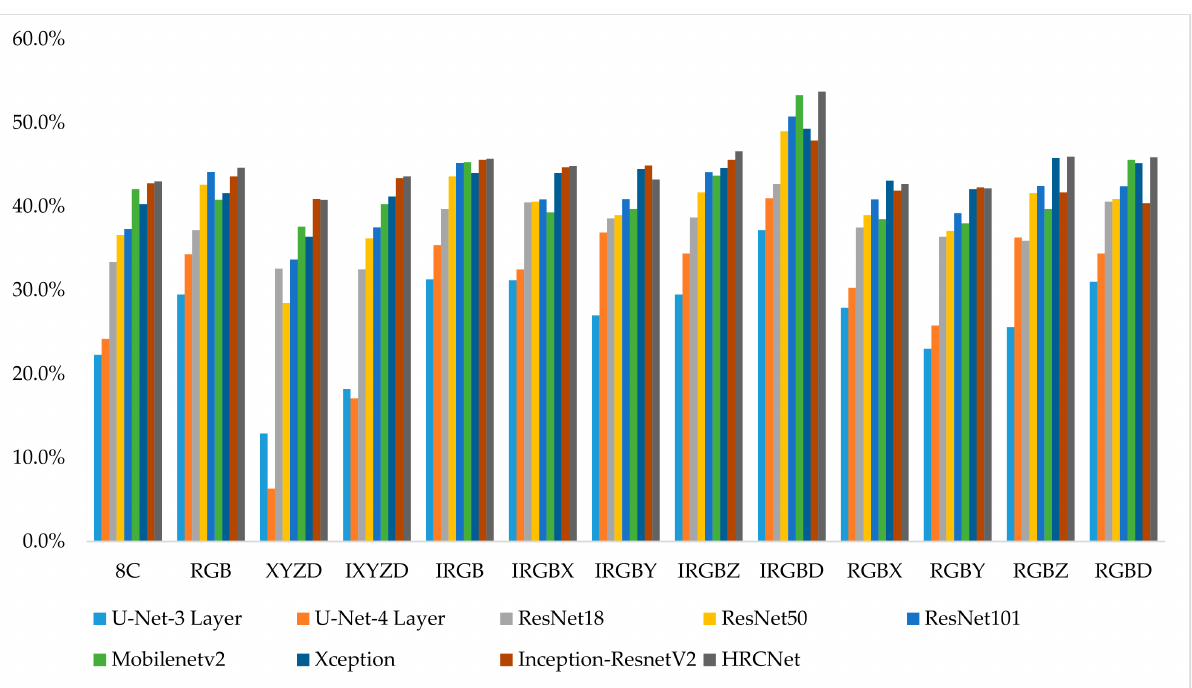
Figure 3. Mean intersection over union (mIoU) on test point clouds.